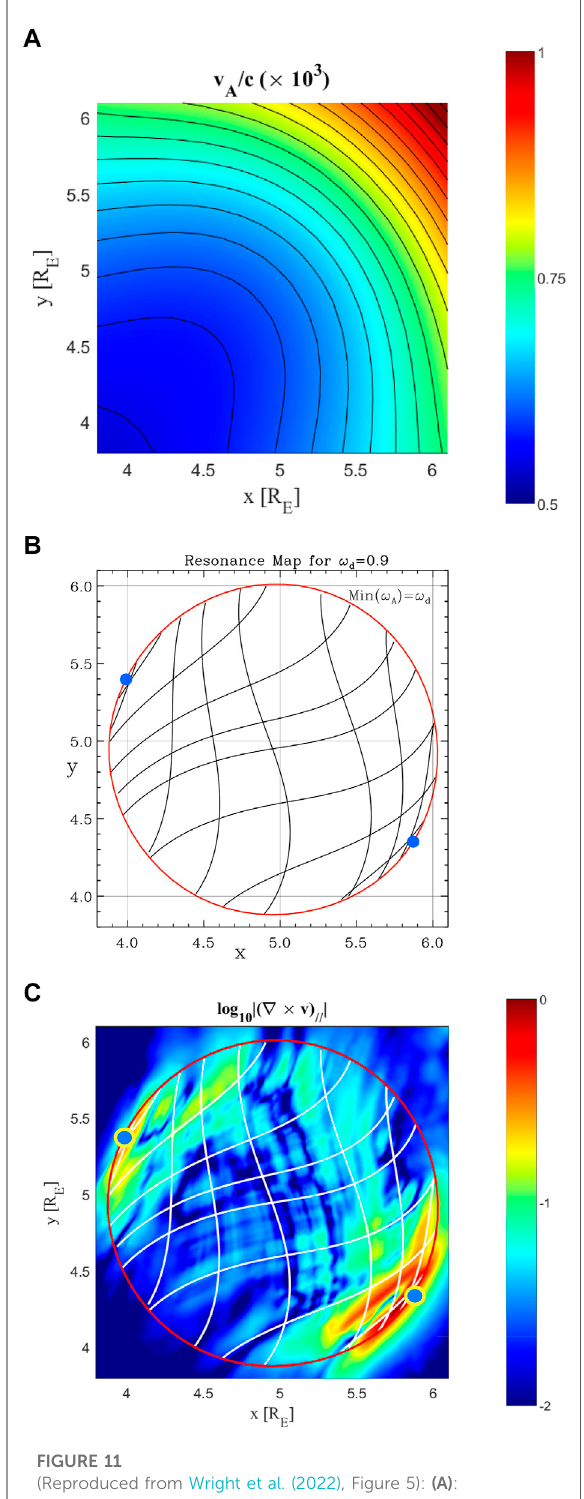
FIGURE 11 (Reproduced from Wright et al. (2022), Figure 5): (A) : EquatorialAlfvénspeedpro fi leintheafternoonsector,showingan alteration due to the addition of a localized peak in density centered at (5, 5); (B) : The Resonance Map in this case for a driver frequency of 0.9 mHz, showing a single closed boundary (red curve) and resonance paths from various boundary points